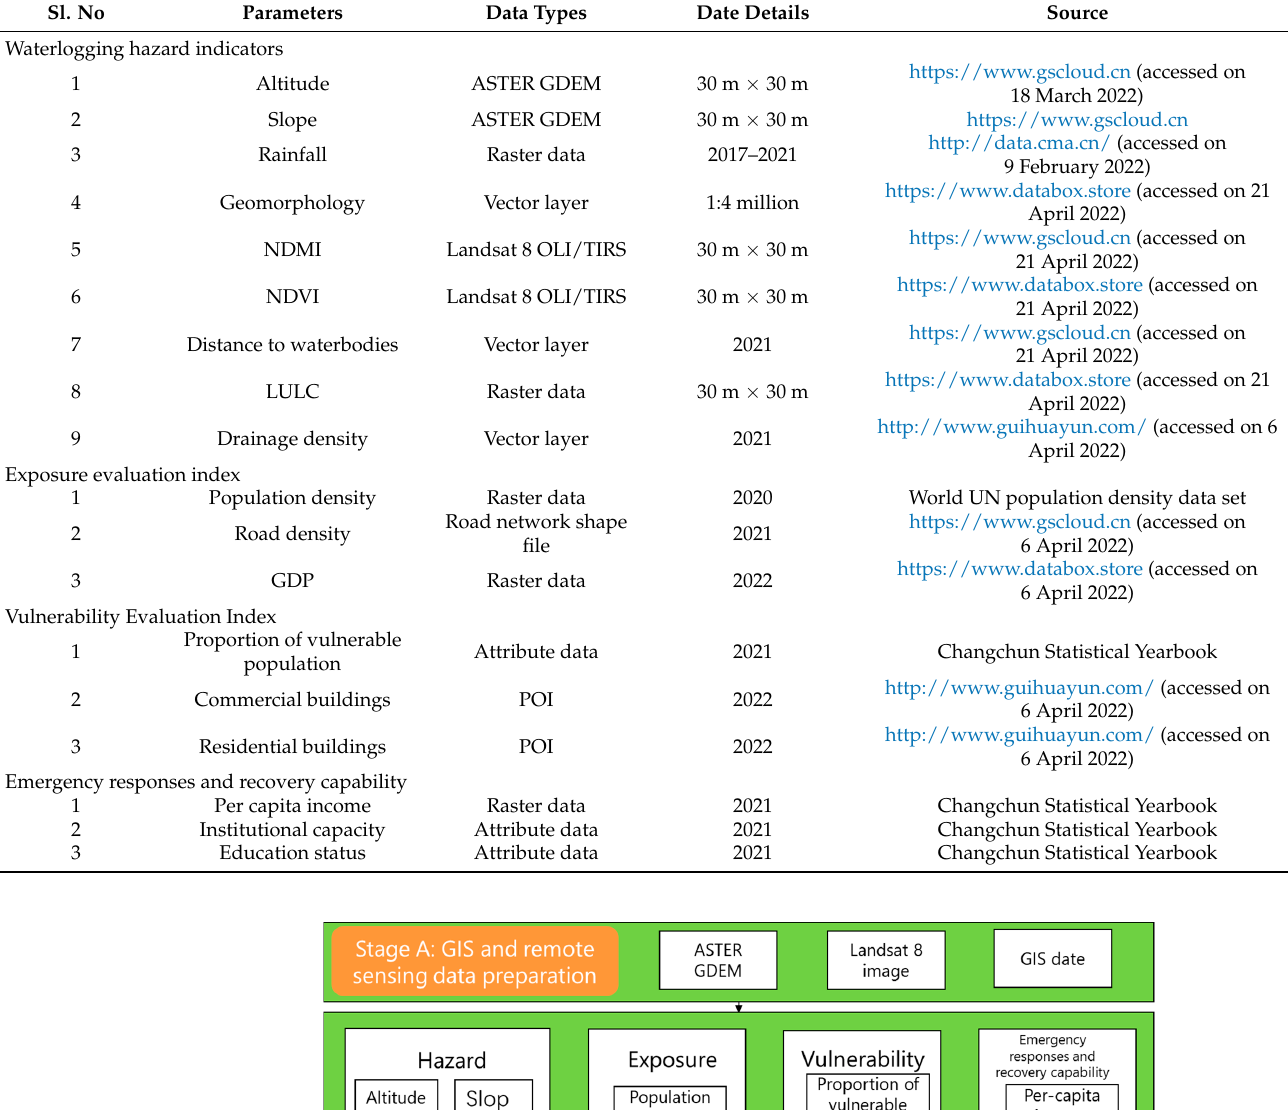
Table 1. Selected indicators of waterlogging risk model and their source.